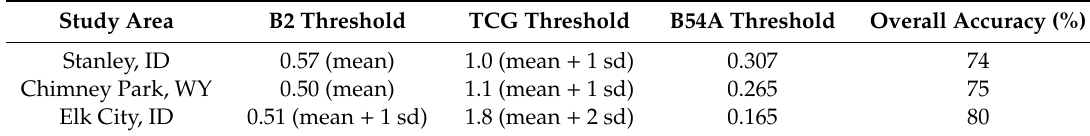
Table 3. Band 2 (B2), tasseled-cap greenness (TCG), and band 5 / band 4 anomaly (B54A) thresholds used to classify non-, disturbed, and undisturbed forest for each study area. B2 and TGC thresholds were used to separate forest from non-forest (values < thresholds corresponded to forest). B54A thresholds were used to separate disturbed from undisturbed forest (values > B54A thresholds indicate disturbed forest). sd = standard